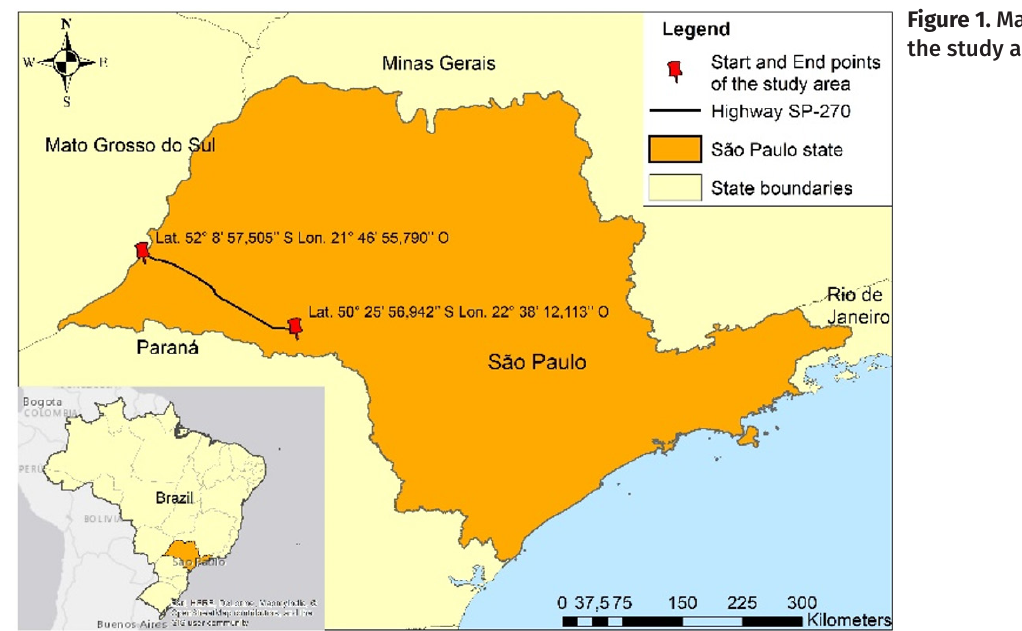
Figure 1. Map of the study